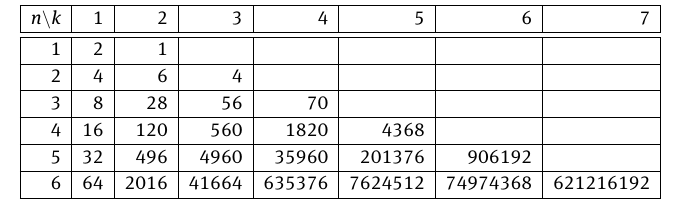
Table 15: Binomial coefficients (cid:0) 2 n n \